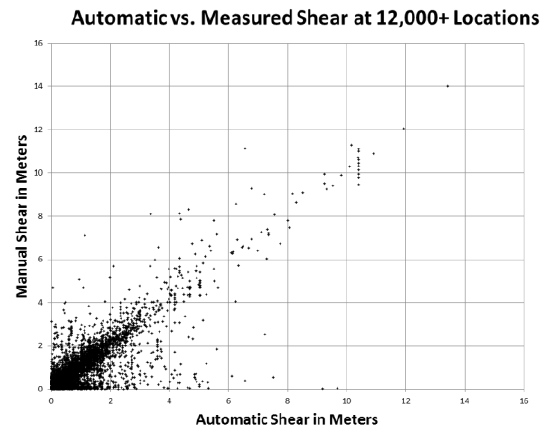
Figure 11: Comparison of over 12,000 manual measurements for image shear to the automated measurements. Offsets from the x=y diagonal indicate human measurement